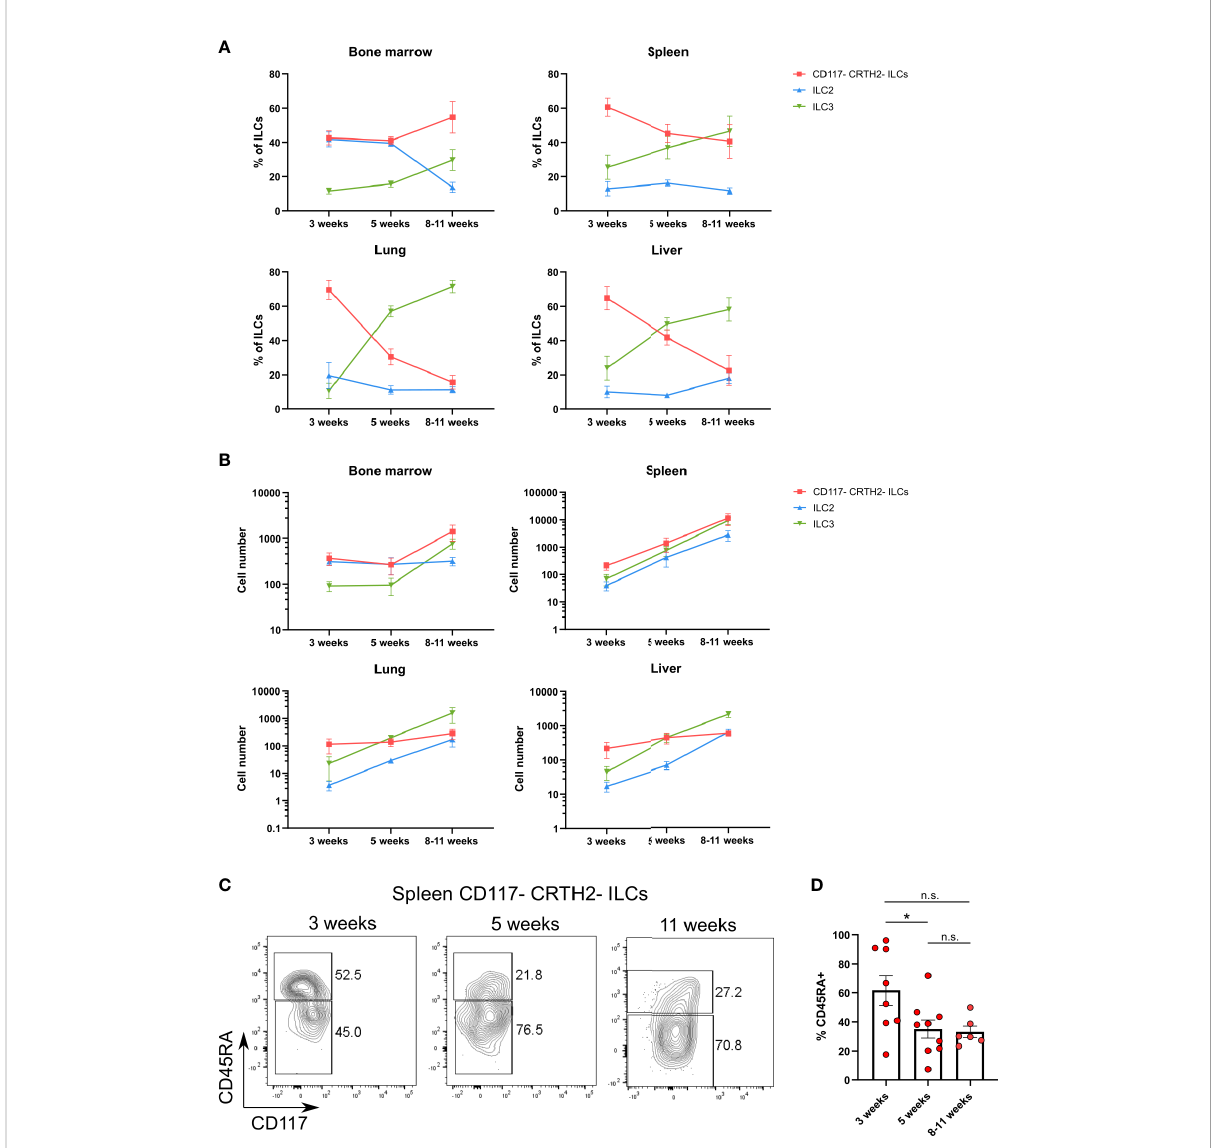
FIGURE 6 CD117 - CRTH2 - CD45RA + ILCs appear early during ontogeny in HSPC-engrafted MISTRG mice. (A, B) Frequencies (A) and numbers (B) of human CD117 - CRTH2 - ILCs, CRTH2 + ILC2s, and CD117 + CRTH2 - ILC3s in bone marrow, spleen, lung, and liver at 3 weeks, 5 weeks, and 8-11 weeks after transplantation of MISTRG mice with human CD34 + HSPCs (n = 6-9 per time-point). ILCs were gated as human CD45 + CD127 + CD94 - CD3 - TCR ab - Lin - cells as in Supplementary Figure 1 and as CD34 - cells. (C) Flow cytometry analysis of human CD117 - CRTH2 - ILCs in the spleen of MISTRG mice at 3, 5, and 11 weeks after transplantation with human CD34 + HSPCs (n = 6-9 per time-point). ILCs were gated as human CD45 + CD127 + CD94 - CD3 - TCR ab - Lin - cells as in Supplementary Figure 1 and as CD34 - cells. (D) Frequency of CD45RA + cells among human CD117 - CRTH2 - ILCs in the spleen of MISTRG mice at 3, 5, and 11 weeks after transplantation with human CD34 + HSPCs (n = 6-9 per time- point). n.s., not signi fi cant; *, P <0.05 by one-way ANOVA, Tukey ’ s post-test. Data represent mean ± SEM and are from two independent